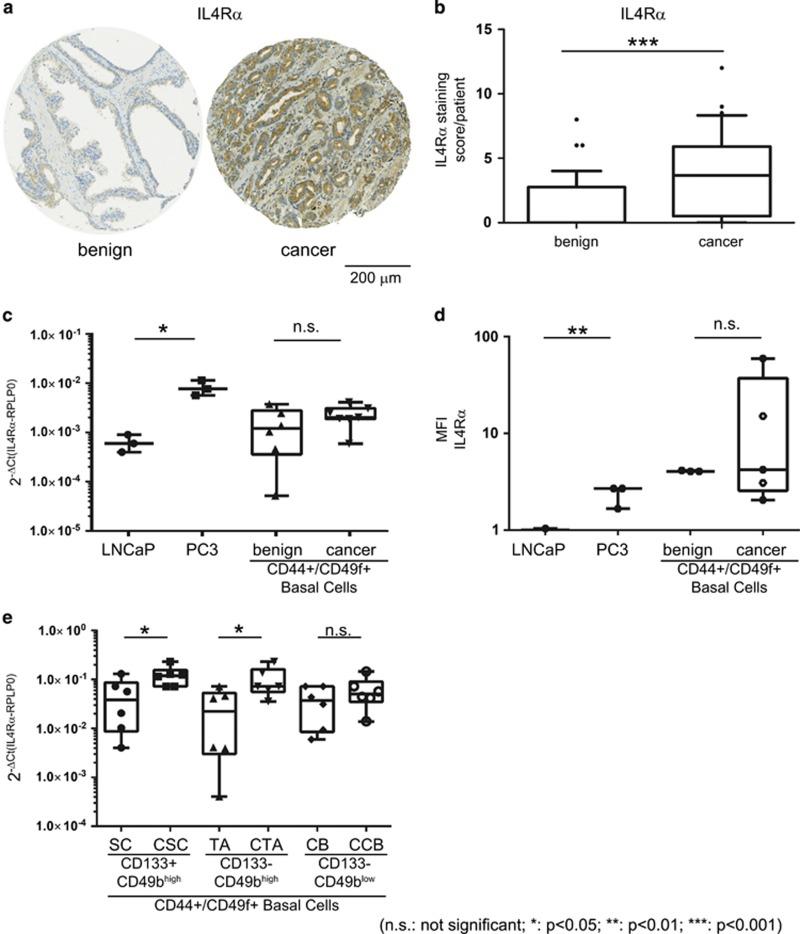
IL4Rα expression in prostate epithelial cells. (a) Immunohistochemical staining for IL4Rα of representative malignant tissue and adjacent benign tissue cores from a PCa patient. Scale bar=200 μm. (b) Evaluation of a TMA of malignant tissue and adjacent benign tissue cores from PCa patients (n=36) stained for expression of IL4Rα. Data are shown as box and whisker diagrams (10–90%, ***P<0.001, outliers are shown as dots). (c) IL4Rα mRNA levels in LNCaP (n=3), PC3 (n=3), benign (n=8) and malignant (n=8) primary prostate cell cultures normalised to RPLP0 expression. Data are shown as box and whisker diagrams (min to max; *P<0.05). (d) IL4Rα protein levels of LNCaP (n=3), PC3 (n=3), benign (n=4) and malignant (n=5) primary prostate cell cultures analysed by flow cytometry. Data are shown as box and whisker diagrams (min to max; *P<0.05; **P<0.01; ***P<0.001). (e) IL4Rα mRNA levels of individual cell subpopulations from benign and malignant primary prostate cell cultures (n=6). Data are shown as Box and whisker diagrams (min to max; *P<0.05). CCB, cancer committed basal; CTA, cancer transit amplifying; NS, not significant.